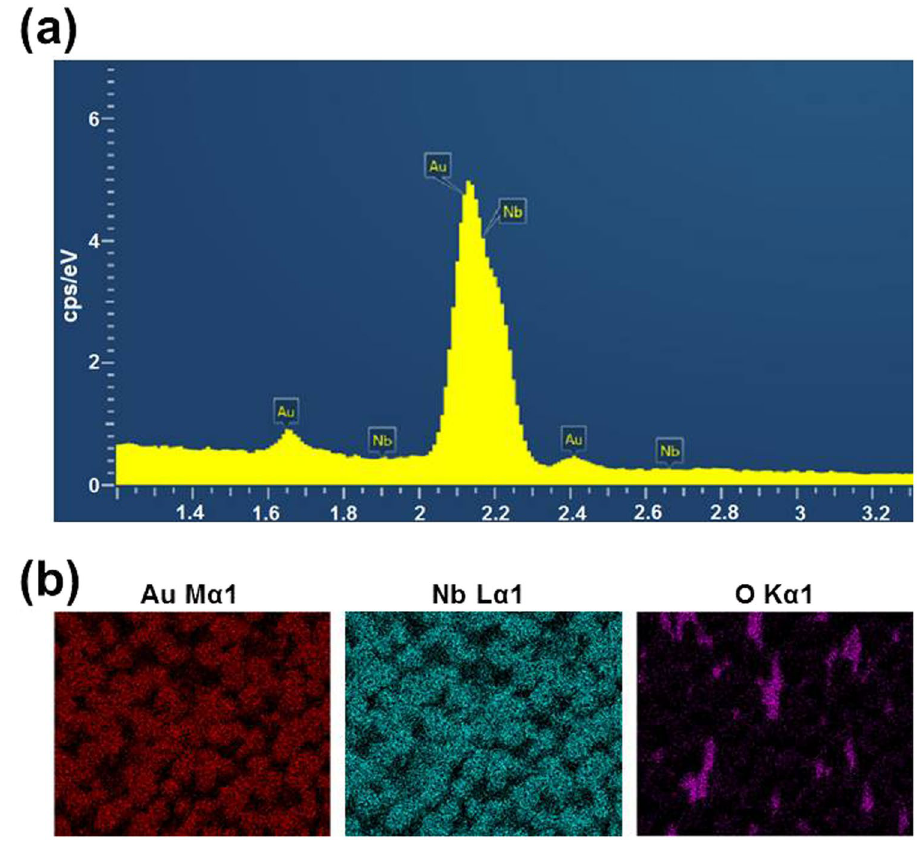
Figure 2. ( a ) EDS spectrum of AuNPs on the LiNbO 3 , containing detectable Au and Nb. ( b ) Element mapping of Au, Nb and